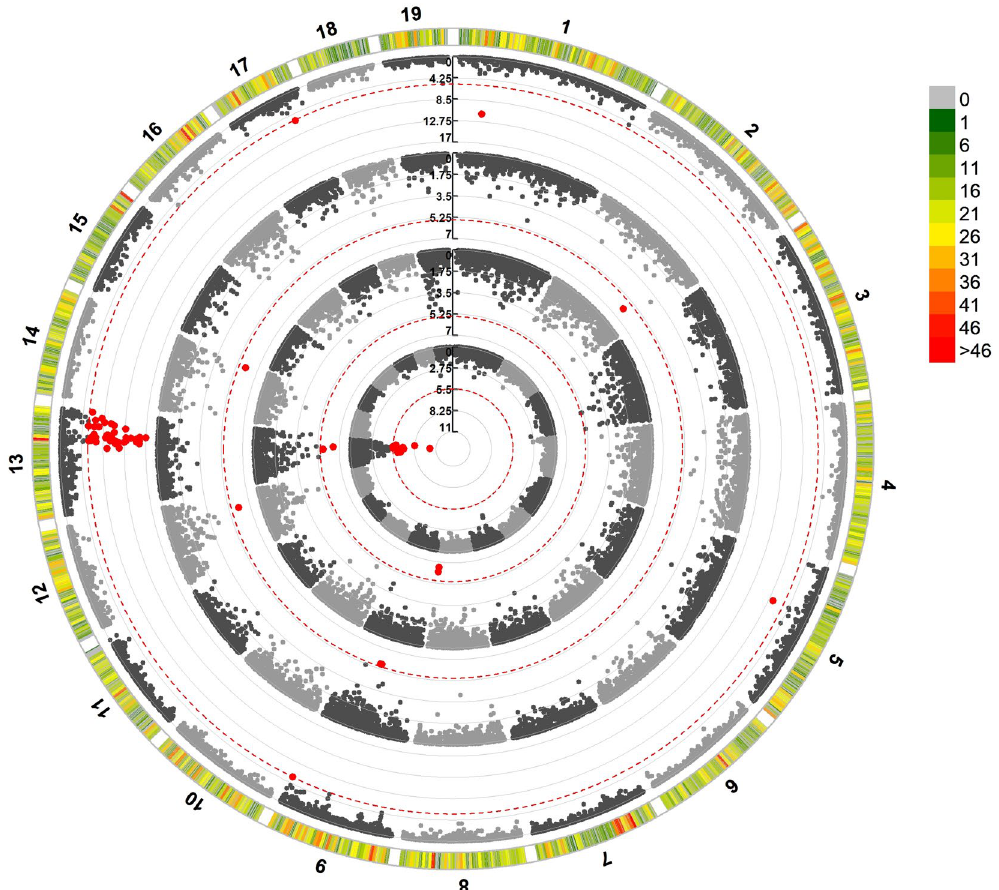
Figure 5. Circular Manhattan plot for SNP significantly associated with shell color and pattern phenotypes in C . edule based on the Mixed Linear Model (MLM). SNP-GWAS circle representations: inner-most: color; first-middle: circle: second-middle: line; and outer-most: stripe. For Manhattan plot, Y-axis represents − log 10 ( p -value) of the association with each SNP and X-axis is physical position in bp. The dashed red lines represent the Bonferroni threshold at genome-wide level ( p ≤ 0.05). SNP markers are represented by gray dots and those above this threshold in red